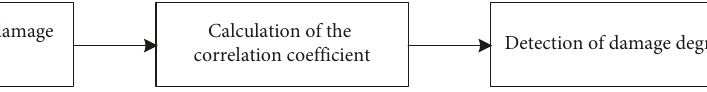
Figure 3: Grey relational analysis chart.